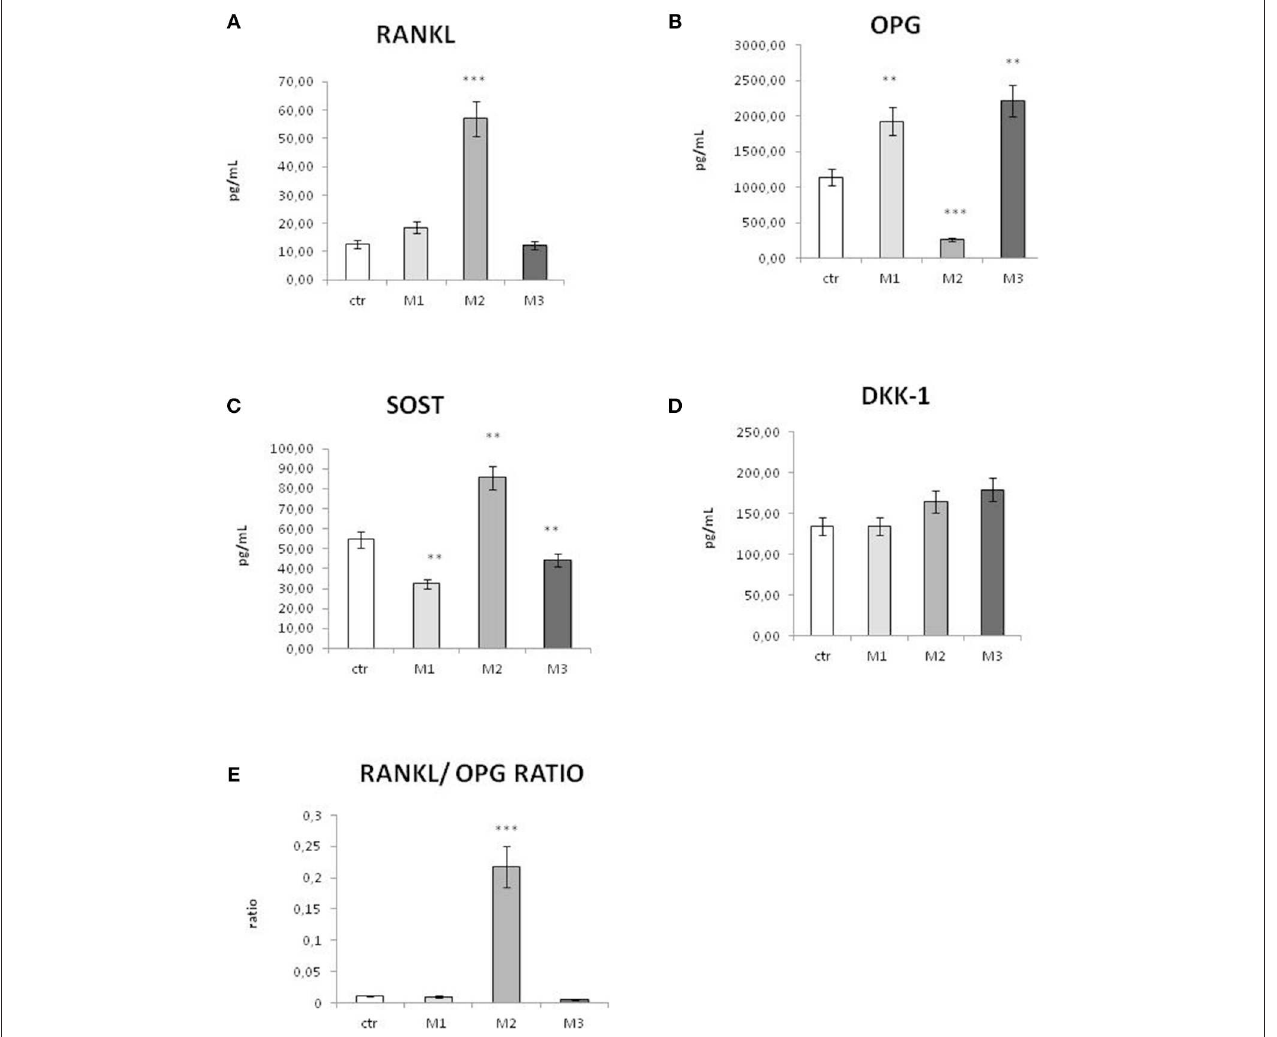
FIGURE 3 | Secretion of osteoimmunological biomarkers in the cell culture supernatant after exposure to M1, M2, and M3 wear debris. Concentrations (picograms per milliliter) of RANKL (A) , OPG (B) , Sclerostin (SOST, C), and DKK-1 (D) , RANKL/OPG ratio (E) in the cell culture supernatant of control (white bar), material M1 (light gray bars), material M2 (medium gray bars), material M3 (dark gray bars). Materials M1, M2, M3 are described in the Methods section, as follows: Material M1a moderately cross-linked vitamin E-blended UHMWPE, EtO sterilized; Material M2 standard UHMWPE (without vitamin E and not cross-linked), EtO sterilized; Material M3 vitamin E-blended UHMWPE not cross-linked, EtO sterilized. Control (white bar) Material M1 (light gray bar), material M2 (medium gray bar), material M3 (dark gray bar). * p < 0.05, statistically significant; ** p < 0.01; *** p <